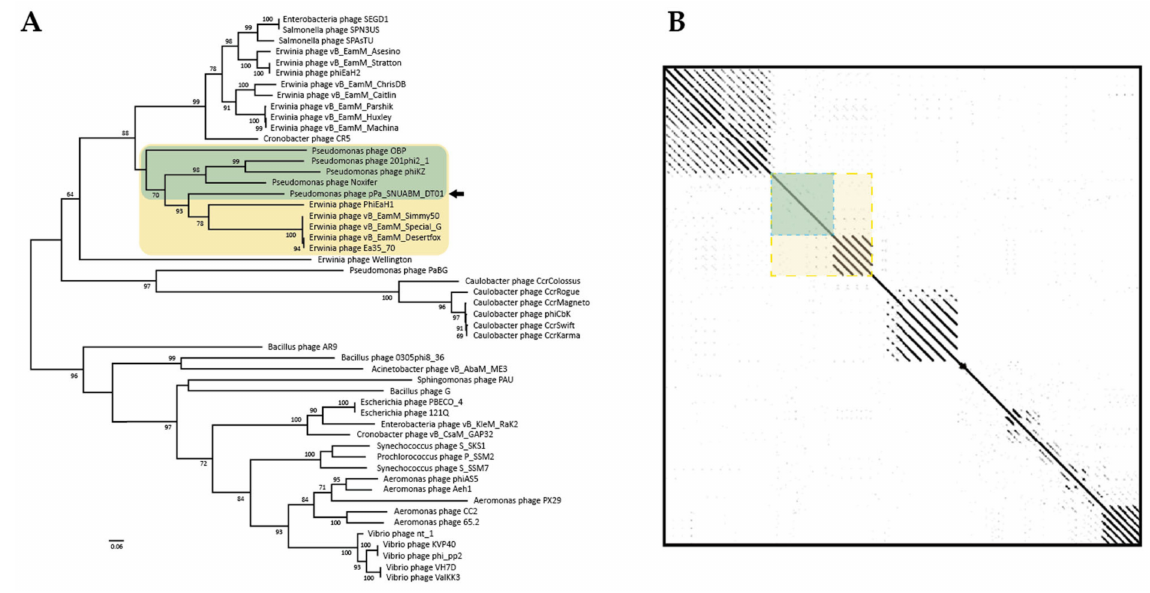
Figure 6. Conserved gene (terminase large subunit) comparison of pPa_SNUABM_DT01 and jumbo-phages. Yellow box: the cluster including pPa_SNUABM_DT01. Green box: the phages do not show diagonal lines in the cluster (Yellow box). ( A ) Phylogenetic tree constructed using MEGA-X by maximum-likelihood with major capsid protein sequences of pPa_SNUABM_DT01 and jumbo-phages. ( B ) Dot plot constructed with concatenated genome sequences used in phylogeny at a word size of